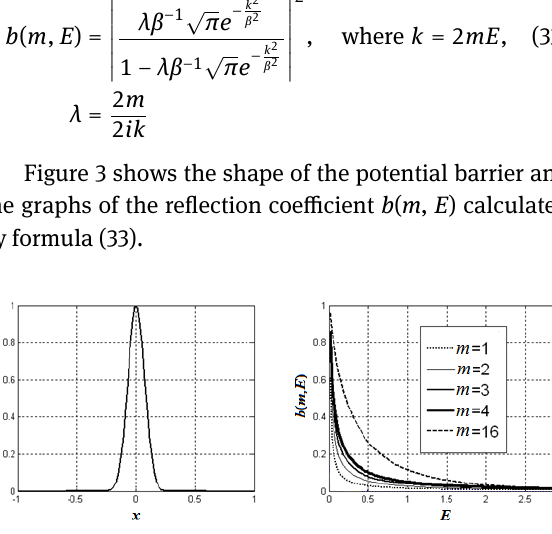
Figure 3: Single barrier (left) and reflection coeflcient depending on particle energy (right)